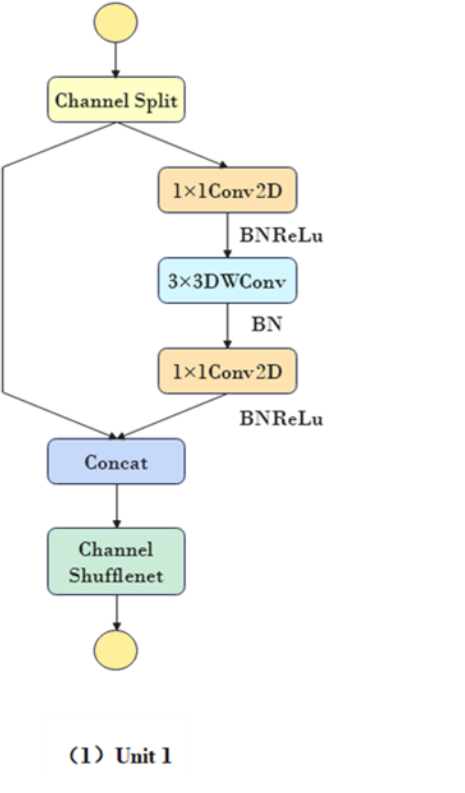
Figure 4. ShuffleNetv2 module diagram.